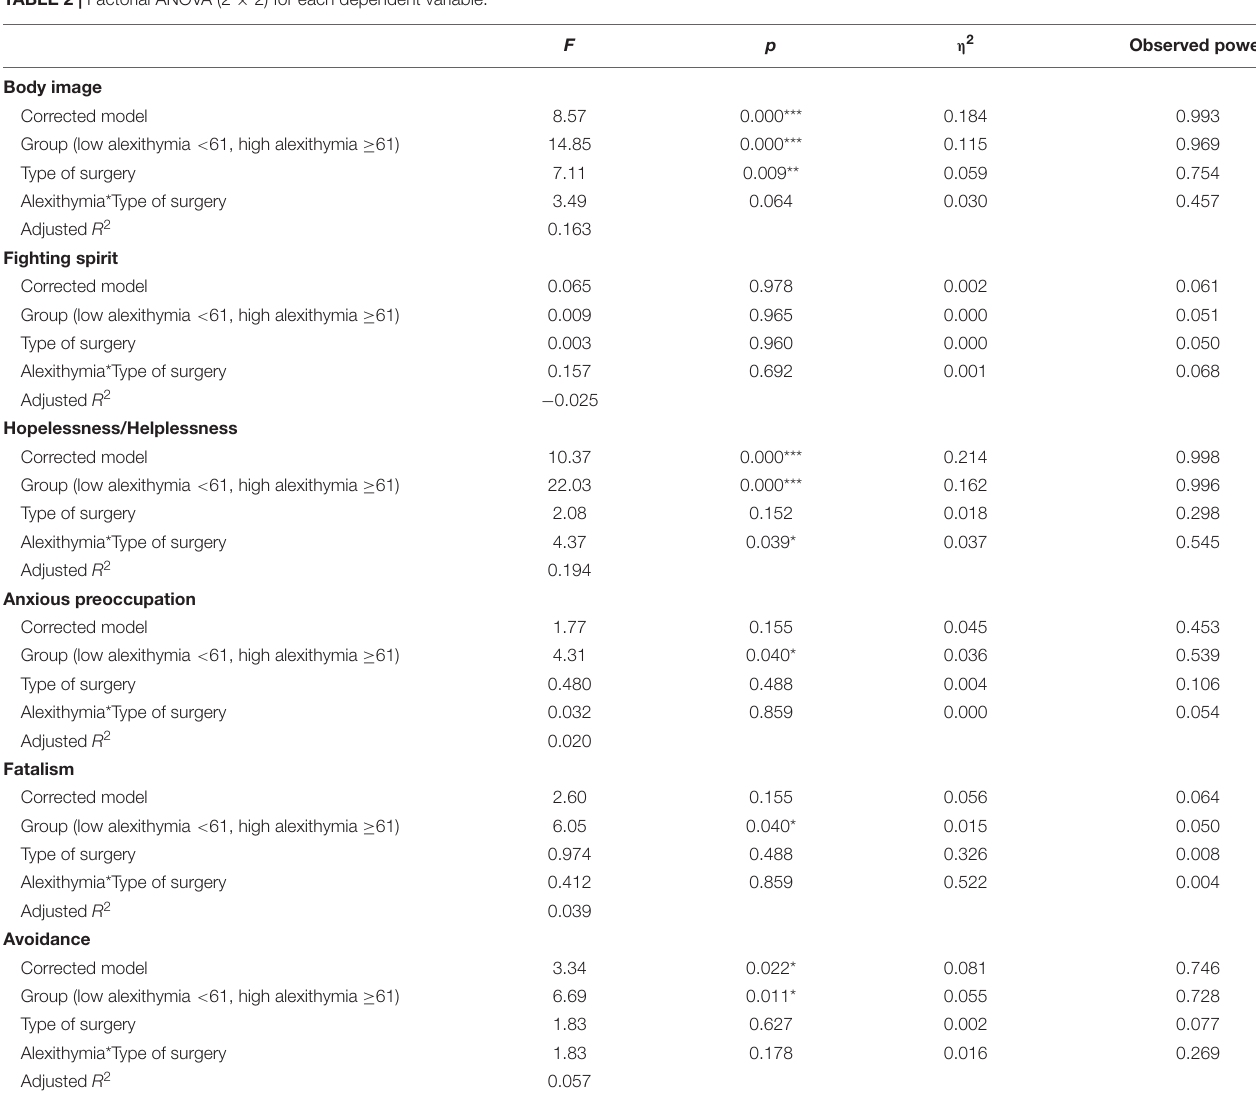
TABLE 2 | Factorial ANOVA (2 × 2) for each dependent